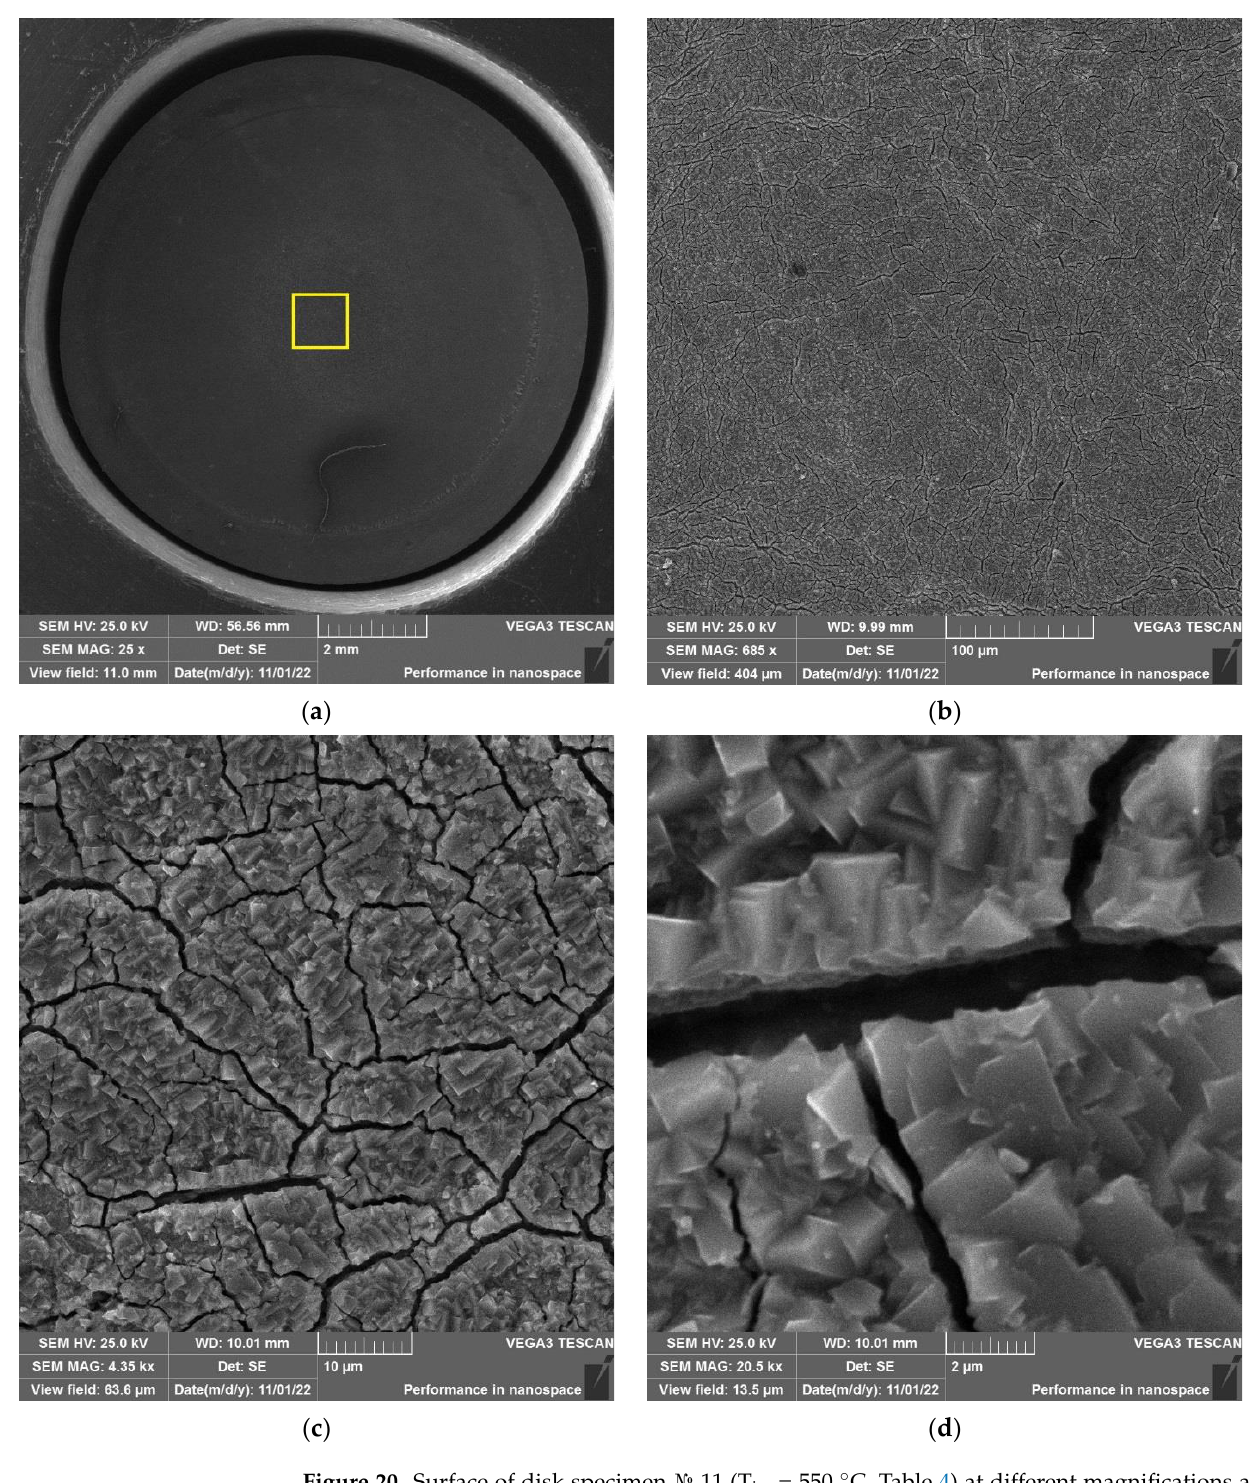
Figure 20. Surface of disk specimen № 11 (T irr = 550 °C, Table 4) at different magnifications after autoclave SCC tests with a load value of 356 N and additional loading up to 6102 N.